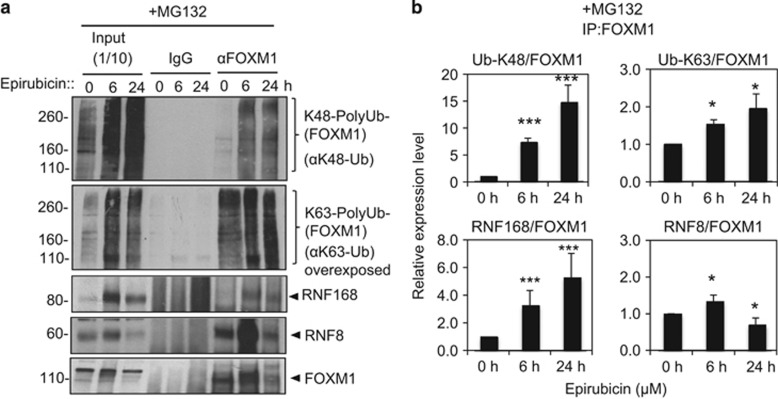
The downregulation of FOXM1 expression by epirubicin is associated with an increase in RNF168 binding and an increase in Lys48-linked polyubiquitin conjugates in MCF-7 cells. (a) Protein lysates prepared from MCF-7 and cells at 0, 6 and 24 h following treatment with 1 μm epirubicin were subjected to immunoprecipitation with a FOXM1 antibody (αFOXM1). The input and immunoprecipitates were then analysed by western blot analysis using antibodies against K48-linked ubiquitin, K63-linked ubiquitin, RNF168, RNF8 and FOXM1. Representative co-immunprecipitation results are shown. (b) The K48-linked polyubiquitin, K63-linked polyubiquitin, RNF168, RNF8 and FOXM1 images were quantified using ImageJ analysis and plotted against signals at 0 h. The ratios of K48-Ub- and K63-Ub-conjugated FOXM1 relative to FOXM1 precipitates as well as FOXM1 bound RNF168 and RNF8 relative to FOXM1 precipitates were also shown. Data shown represent the mean±s.d. from three independent experiments (t-test: 6 h or 24 h versus 0 h epirubicin treatment; *significant P<0.05, and ***very significant P<0.001). ANOVA was also performed on these data with post hoc test.